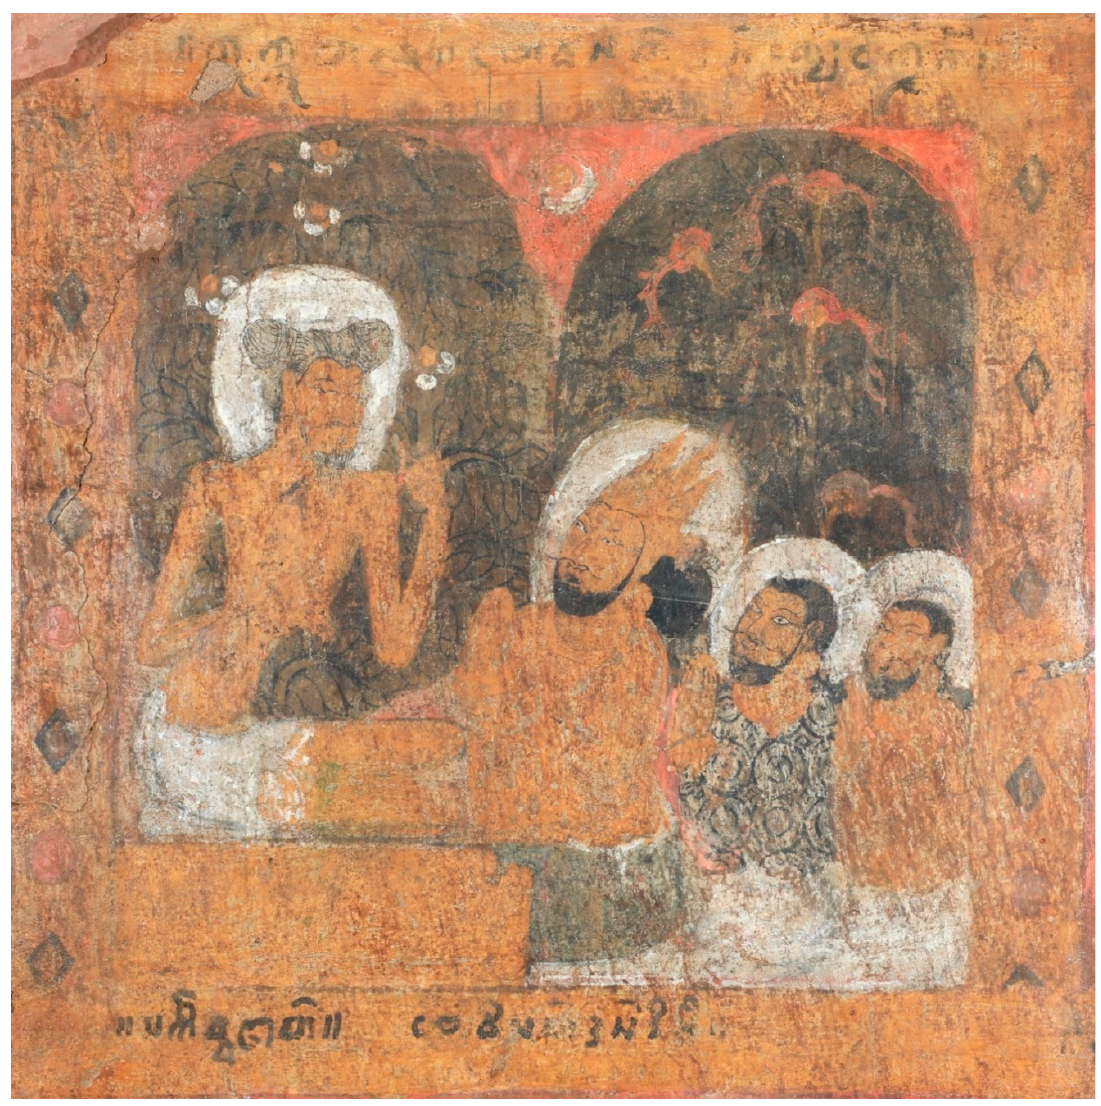
Figure 23. Pagan, Myinkaba Kubyaukgyi 1112 AD. Samkicca Jataka 530.